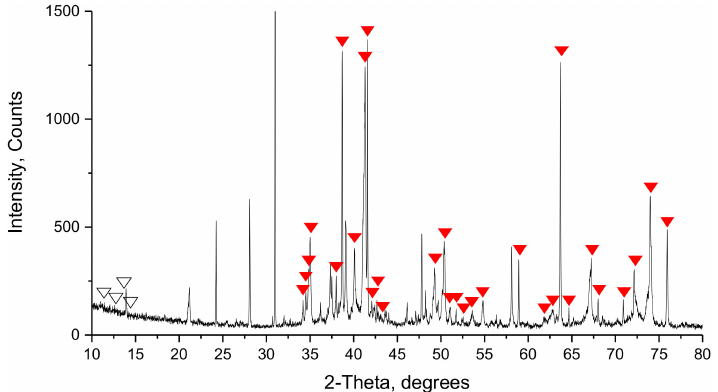
Figure 20. Detailed view on the powder diffractogram of the SM-S sinter. The solid red triangles mark the positions of SFCA covered under diffraction patterns of other phases and the blank triangles mark the positions of SFCA, where SFCA patterns are missing in the